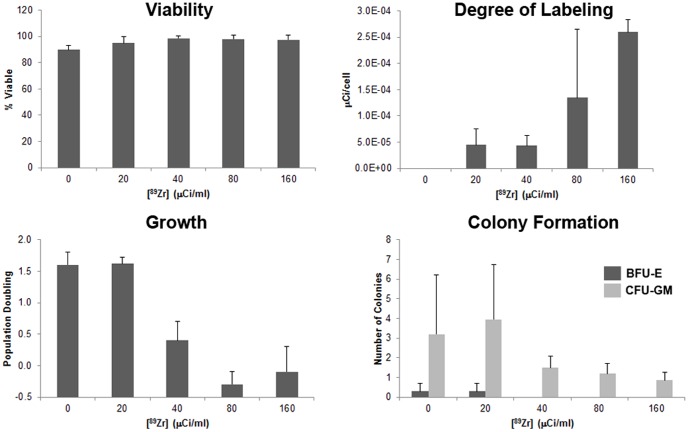

89Zr-Df-CD45 radiolabeling of hPBSC.hPBSC were labeled with 0, 20, 40, 80, or 160 µCi/mL of 89Zr-Df-CD45. No significant changes in cell viability were observed with increasing concentrations. However, a greater degree of radiolabeling was observed with 80 and 160 µCi/mL of 89Zr-Df-CD45. A decline in cell growth and colony formation was noted when cells were incubated with 89Zr-Df-CD45 at a concentration >20 µ/mL.